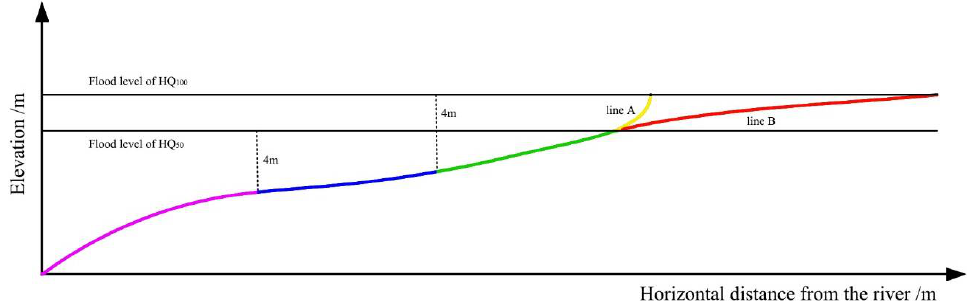
Figure 13. Schematic diagram of the topography of the river bank in one side.